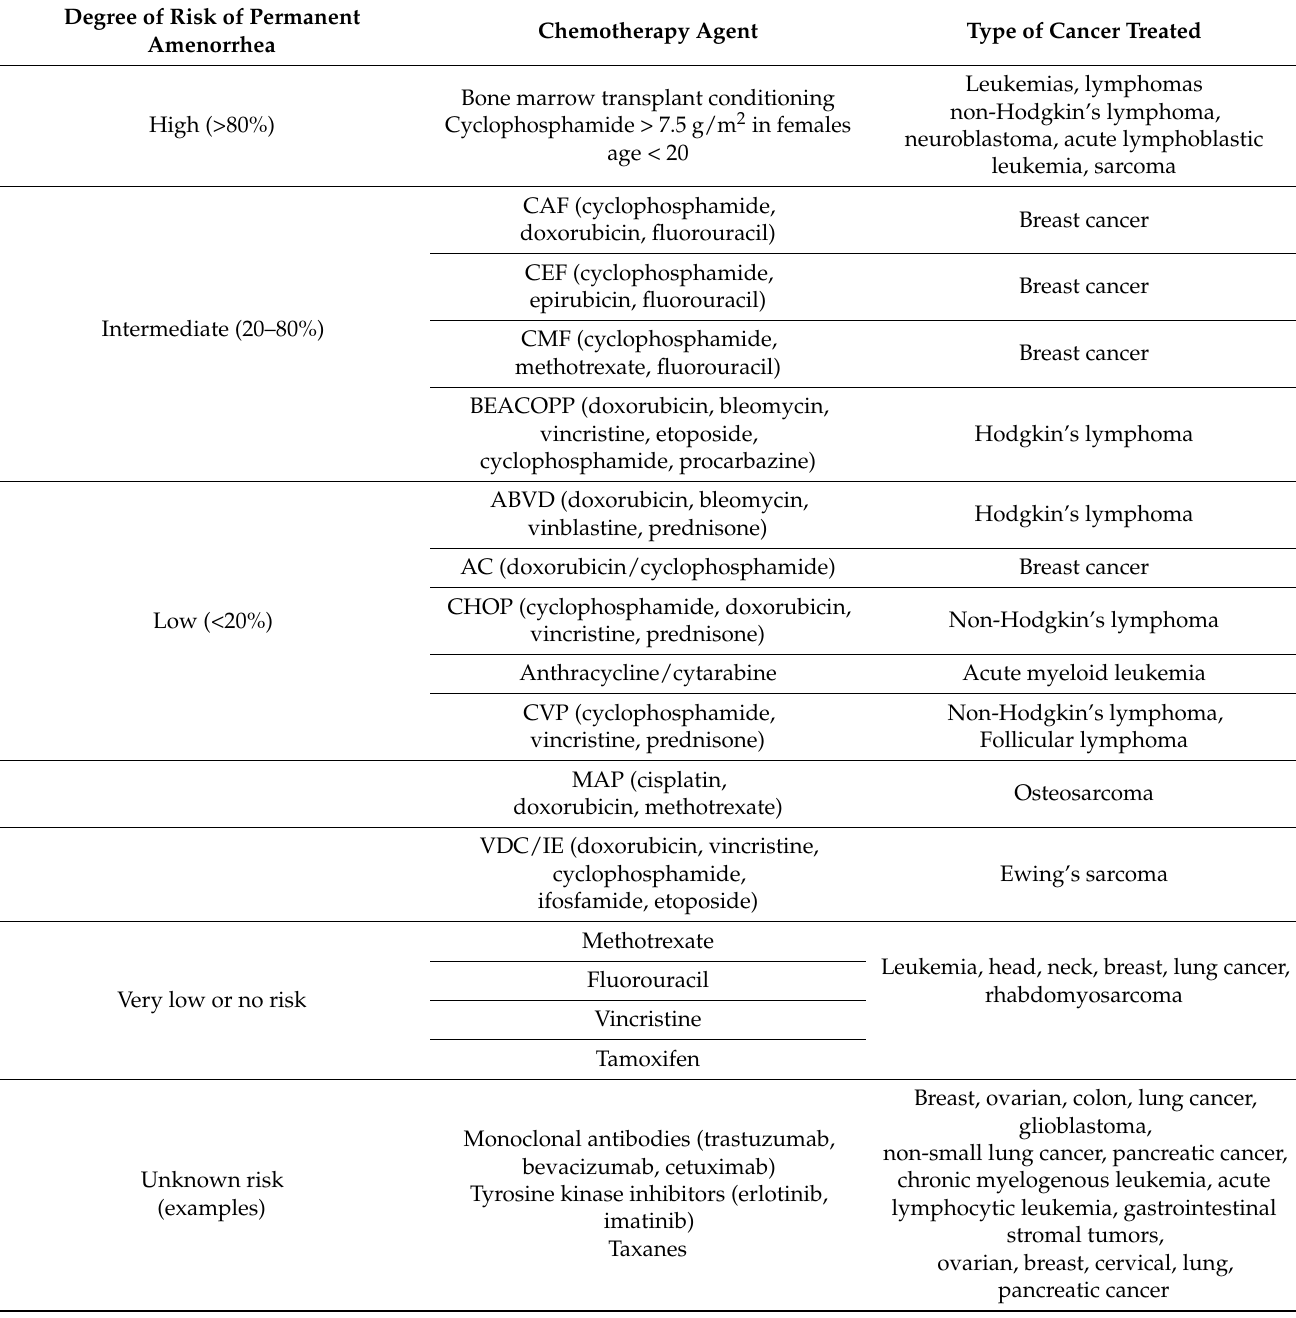
Table 1. List of chemotherapy protocols with gonadal toxicity potential based on ASCO (American Society of Clinical Oncology) recommendations on fertility preservation [12–14]. Note: Table contains examples and is not a complete